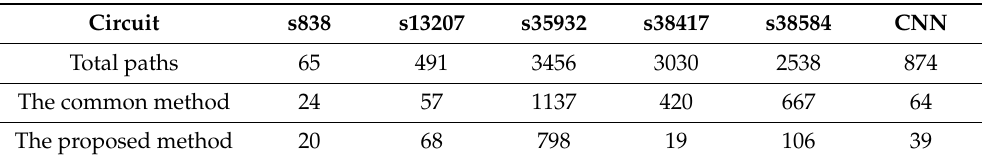
Table 4. The number of monitored points selected by different methods in ISCAS’89 benchmark circuits [33] and the circuit of a CNN